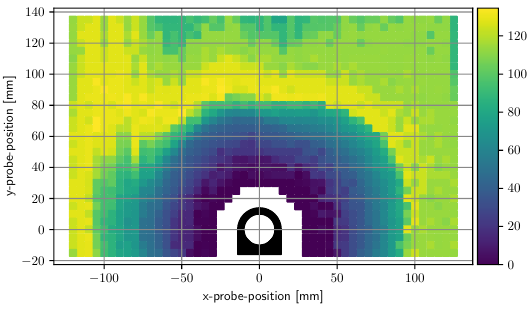
Figure 8. Superimposed plot of spatial resolutions from all of the four